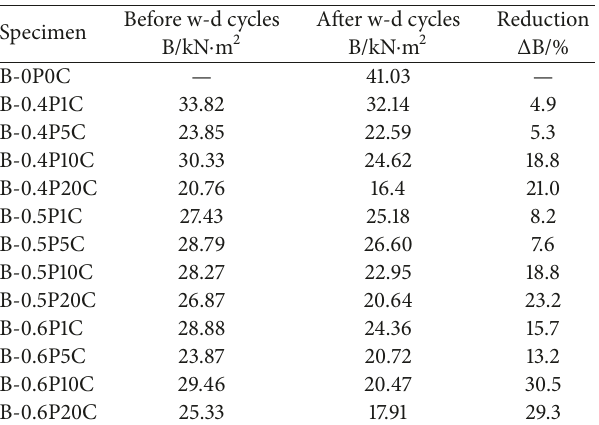
Table 6: Comparison of bending rigidity of specimens between before and after w-d